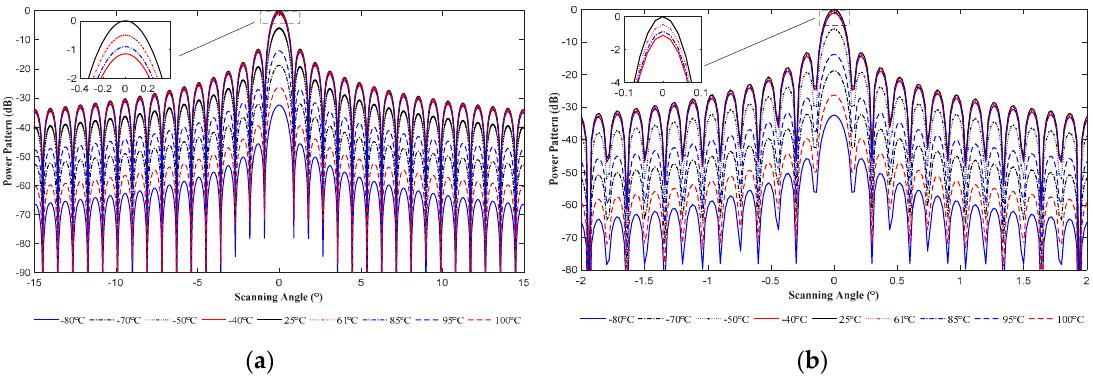
Figure 6. Array antenna with different temperature: ( a ) E-plane pattern; ( b ) H-plane pattern.